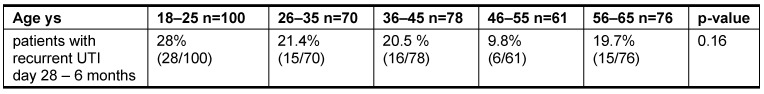
Recurrent UTI/age